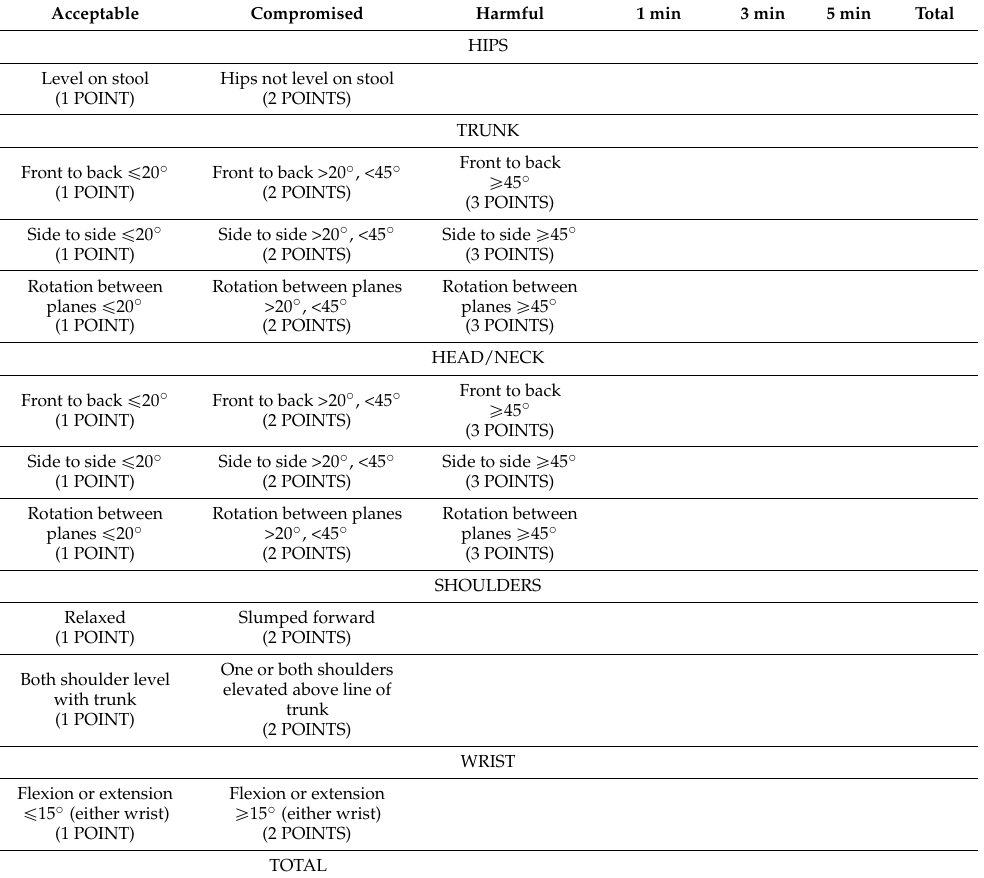
Table 1. Branson’s Dental Operator Posture Assessment Instrument (PAI).